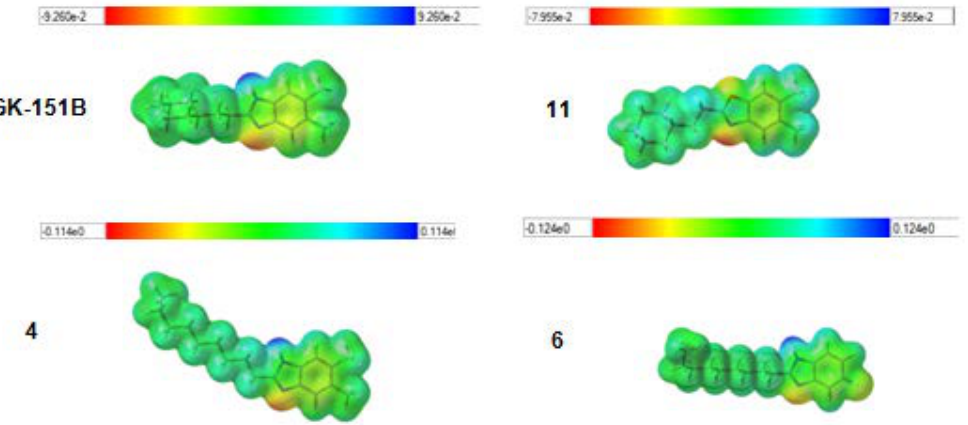
Figure 3. Molecular electrostatic potential (MEP) maps on the isodensity surface calculated at the B3LYP/6-31G(d).